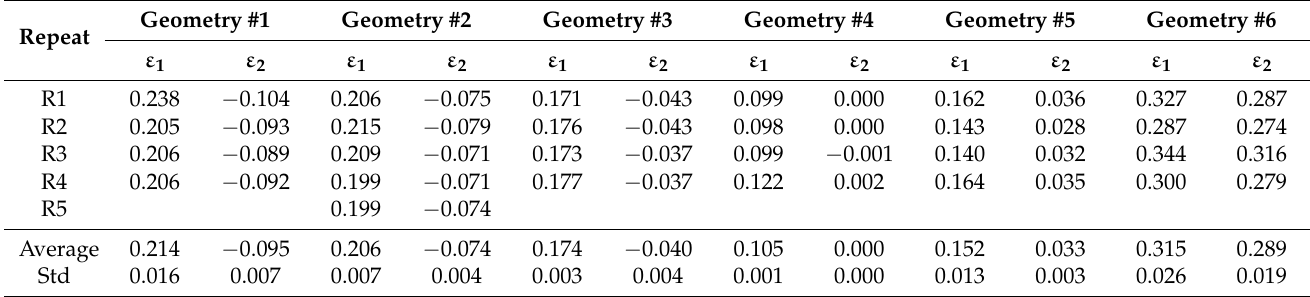
Table A2. Forming limit strains obtained in Marciniak tests for the 3rd Gen 1180